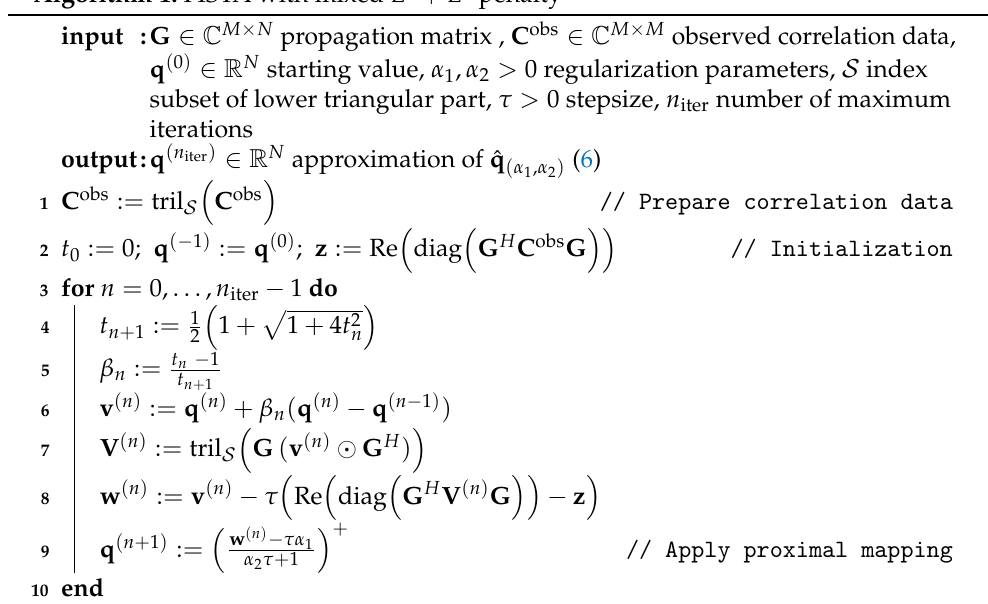
Algorithm 1: FISTA with mixed L 1 + L 2